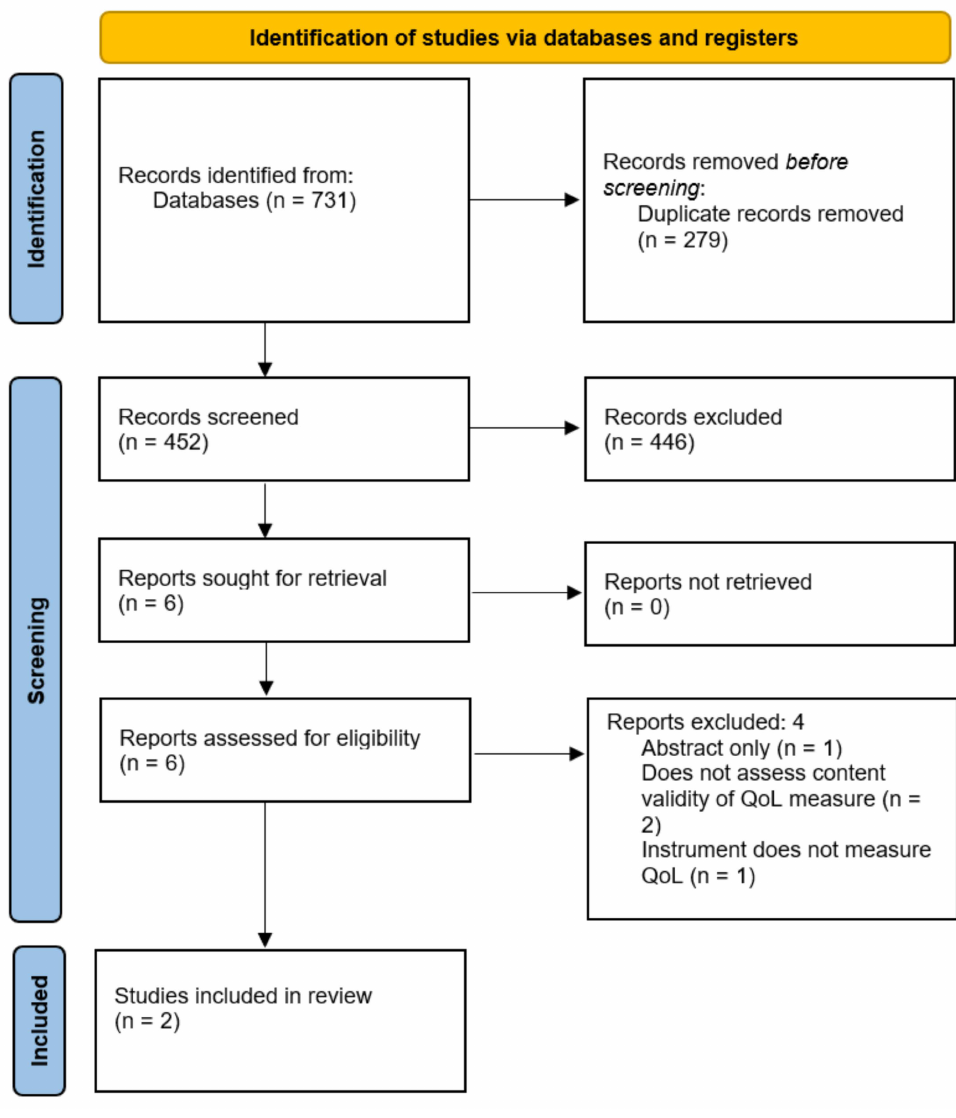
Figure 2. PRISMA diagram. QoL = Quality of